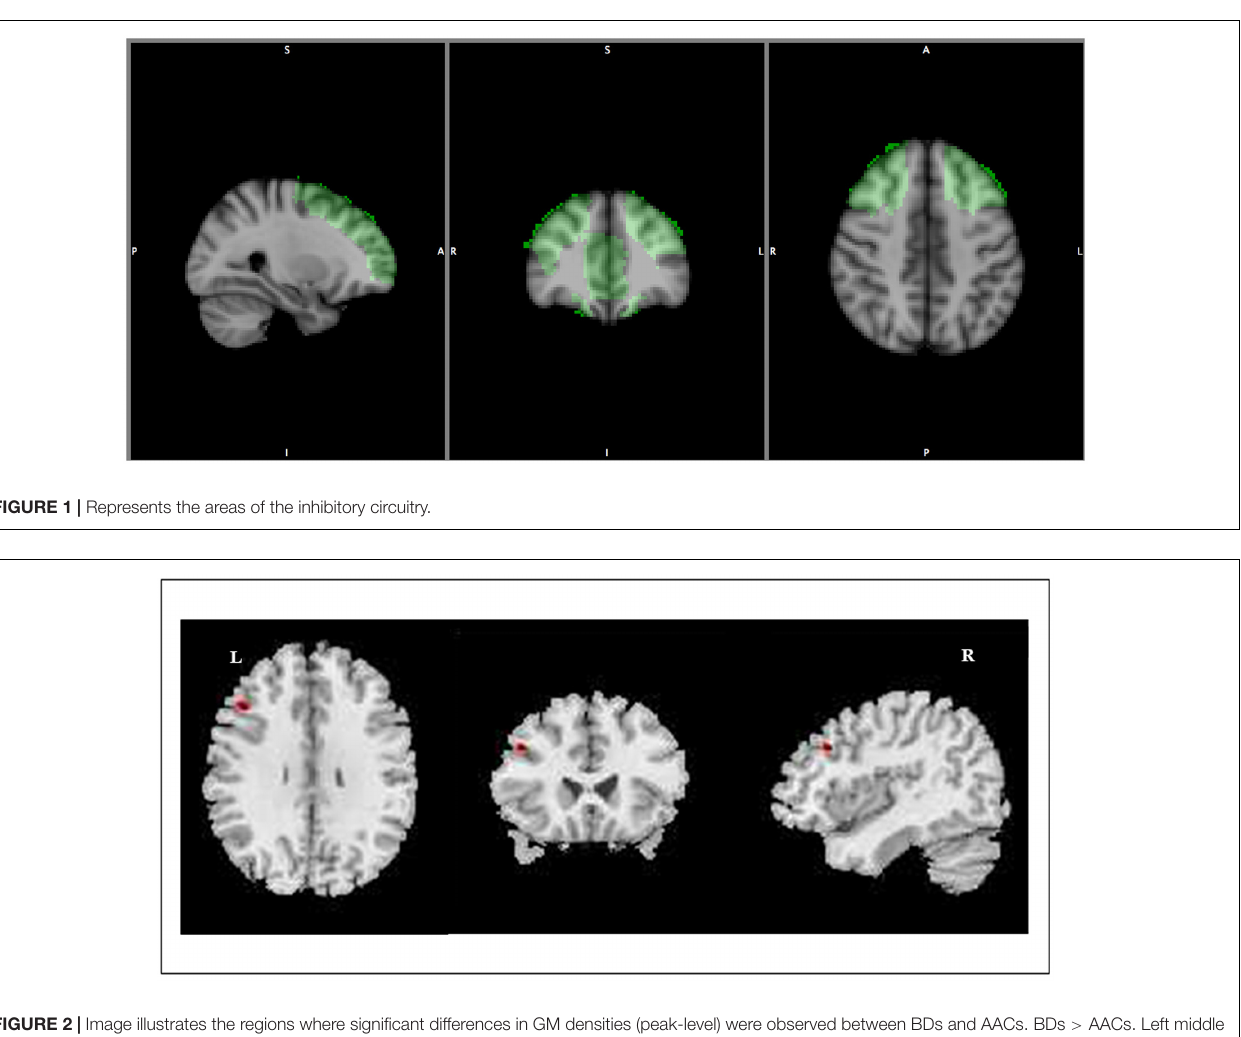
FIGURE 2 | Image illustrates the regions where significant differences in GM densities (peak-level) were observed between BDs and AACs. BDs > AACs. Left middle frontal gyrus, MNI coordinates: –45, 24, 33; K = 315, p < 0.0001. Voxel size: 1.5 mm 3